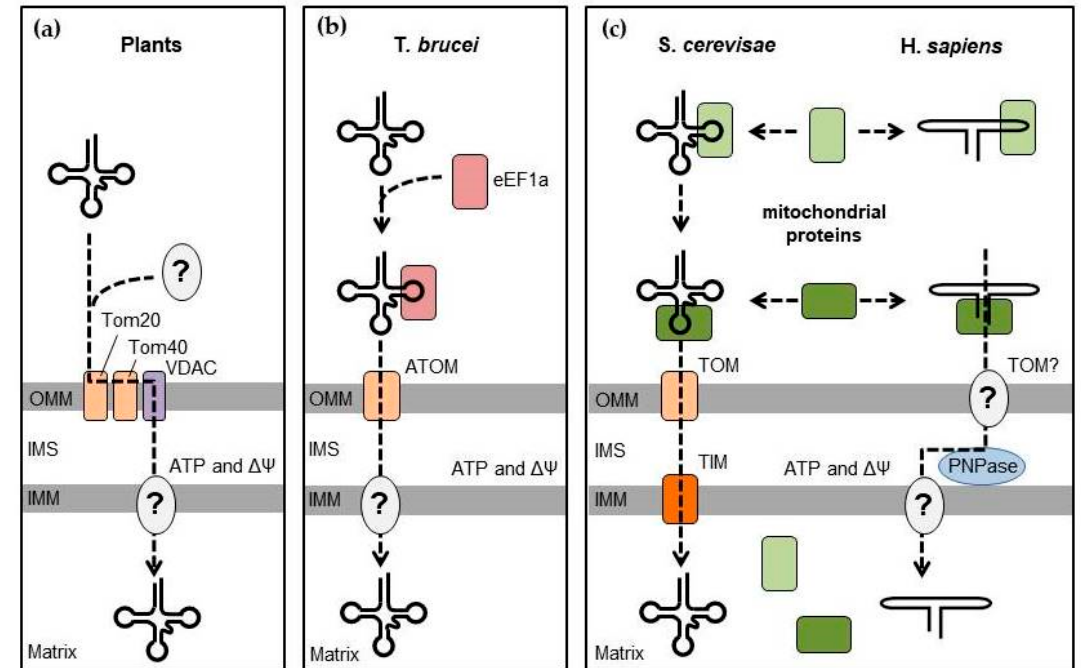
Figure 2. RNA import mechanisms in various eukaryotic models. ( a ) In plants, the targeting of RNA mitochondria probably relies on some unidentified cytosolic factors (e.g., aminoacyl-tRNA synthetases). Translocation across the outer mitochondrial membrane (OMM) requires Tom20, Tom40, involved in the pre-protein import, as well as the voltage-dependent anion channel (VDAC). The